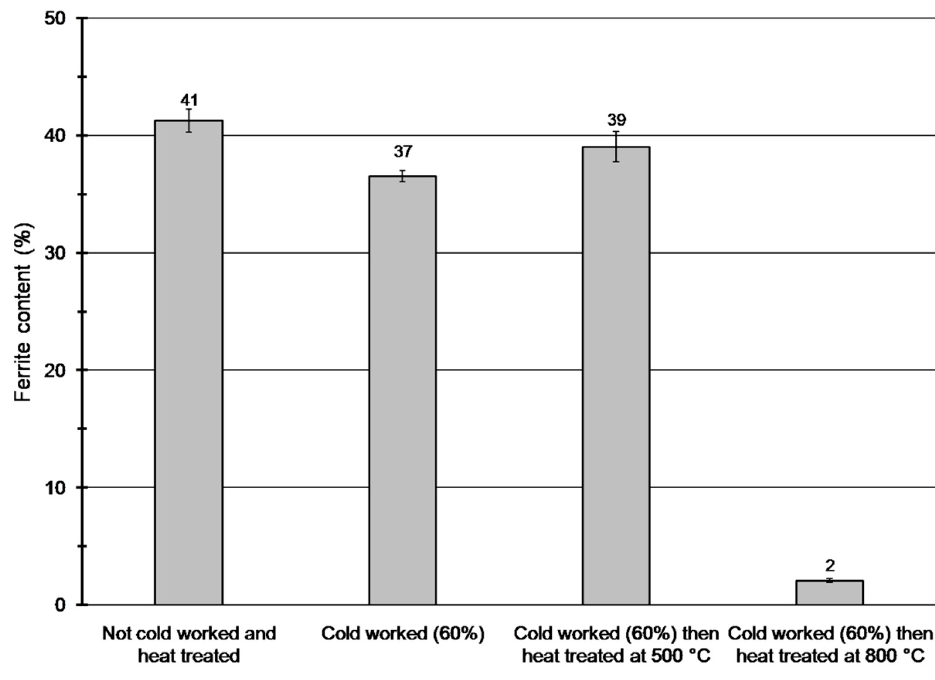
Figure 4. Results of feritscope measurements.